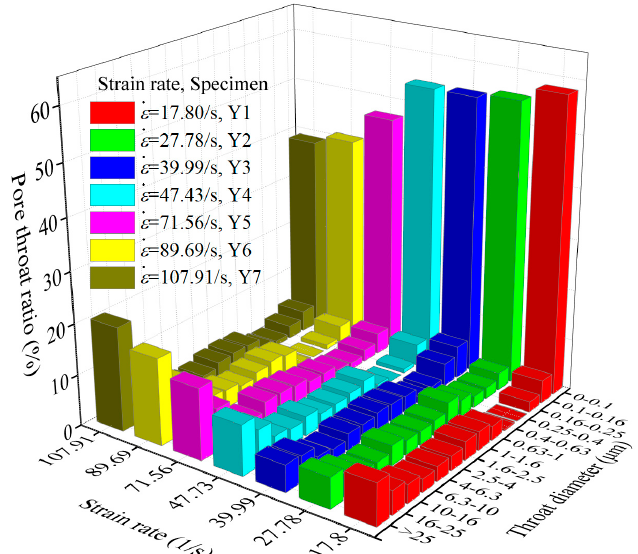
Figure 10. Pore throat distributions at different strain rates within crushed specimens of Xintian coal (prone).